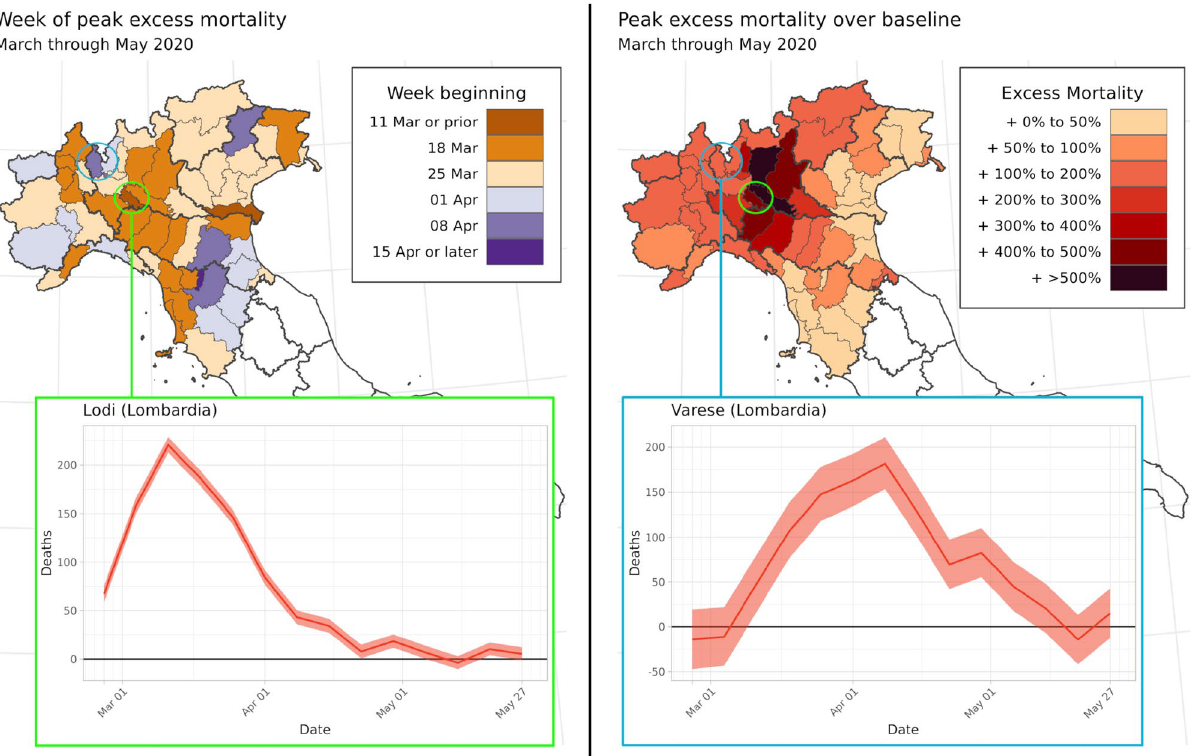
Figure 6. Excess deaths vary across provinces within the Lombardy region. Top left : Map of Northern Italy showing the week when province’s excess mortality was estimated to peak during the first wave of COVID-19 in March through May 2020. Top right : Map of the peak weekly standardized mortality ratio (SMR) for each province across Northern Italy across all weeks in March through May 2020. Bottom left : Estimated excess deaths by week for Lodi province. Bottom right : Estimated excess deaths by week for Varese